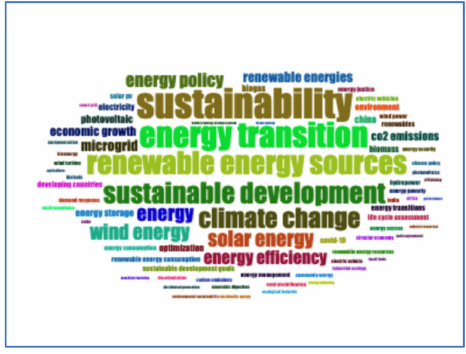
Figure 8. WordCloud of authors’ keywords.